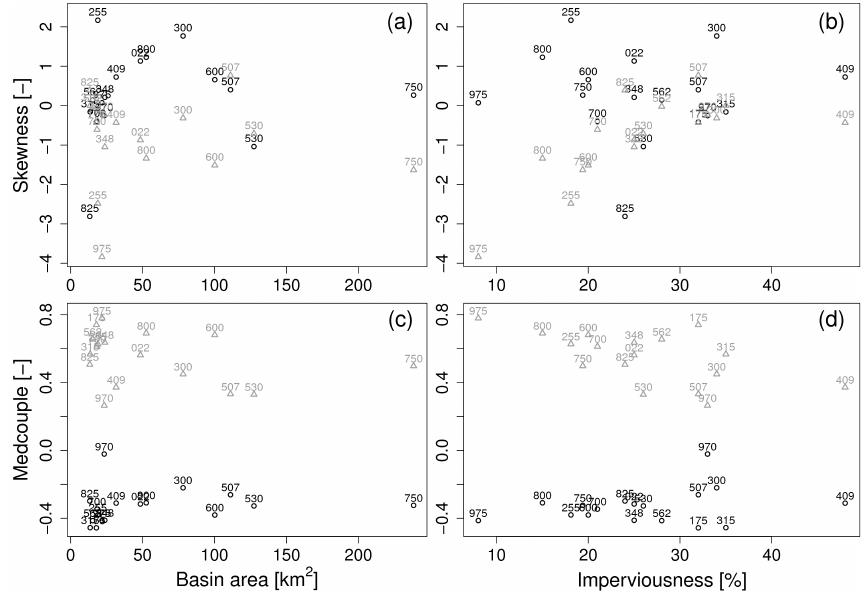
Figure 7. Scatter plots of skewness (a, b) and medcouple values (c, d) of histograms for differences in flows and inter-amount times, plotted versus basin size and imperviousness degree. Grey triangle symbols represent inter-amount times, black circles represent flows.